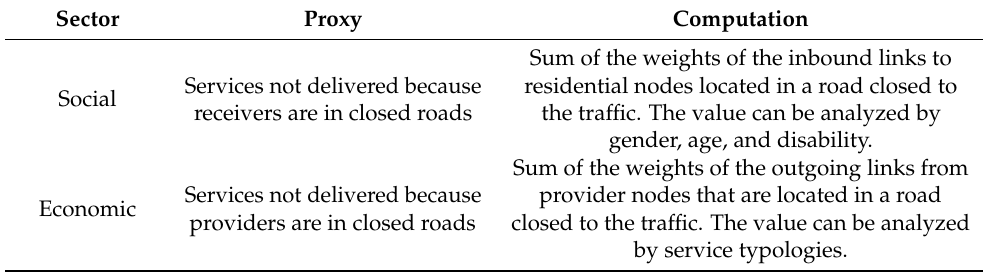
Table 1. Proxy for social and economic